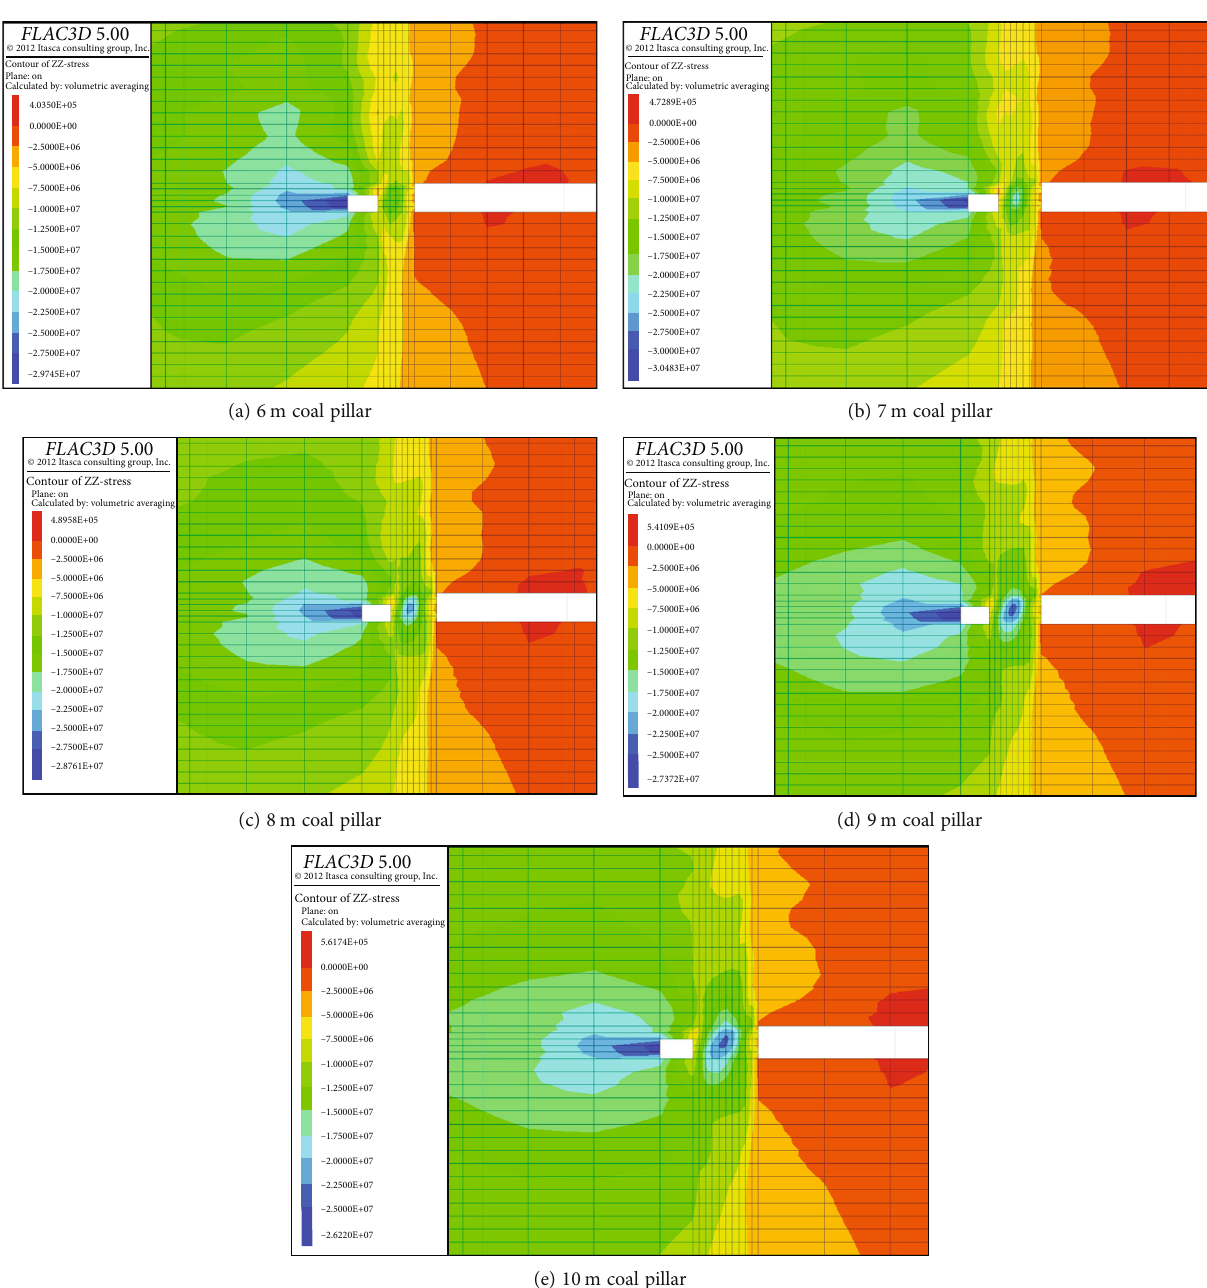
Figure 6: Vertical stress distribution in coal pillars with di ff erent widths and surrounding rock of roadway along goaf when the workface was advanced